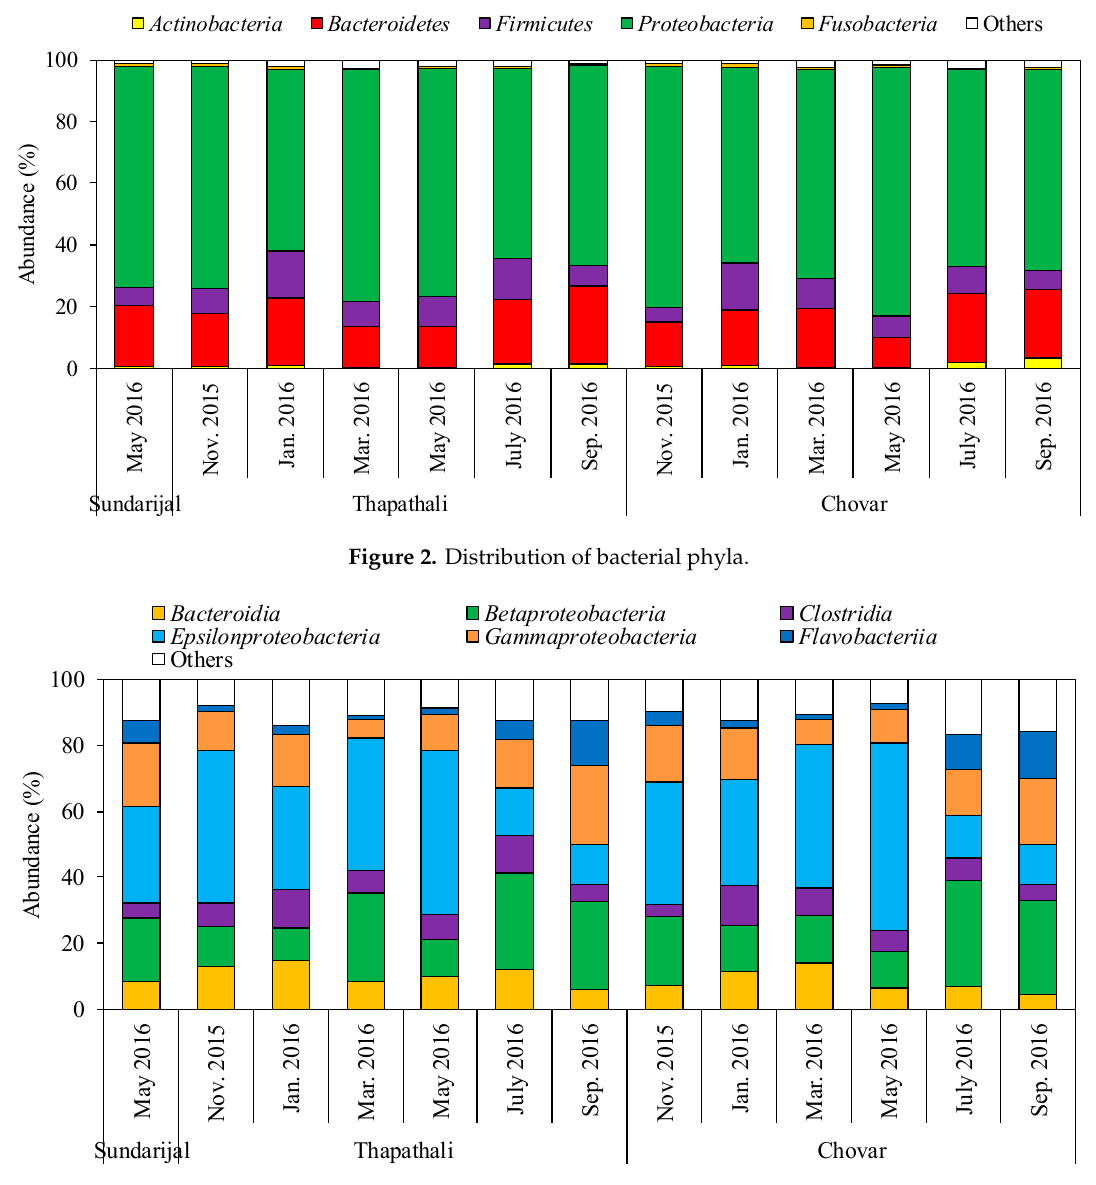
Figure 3. Distribution of bacterial classes. Table 1. Abundance ratios of potential pathogenic bacteria.